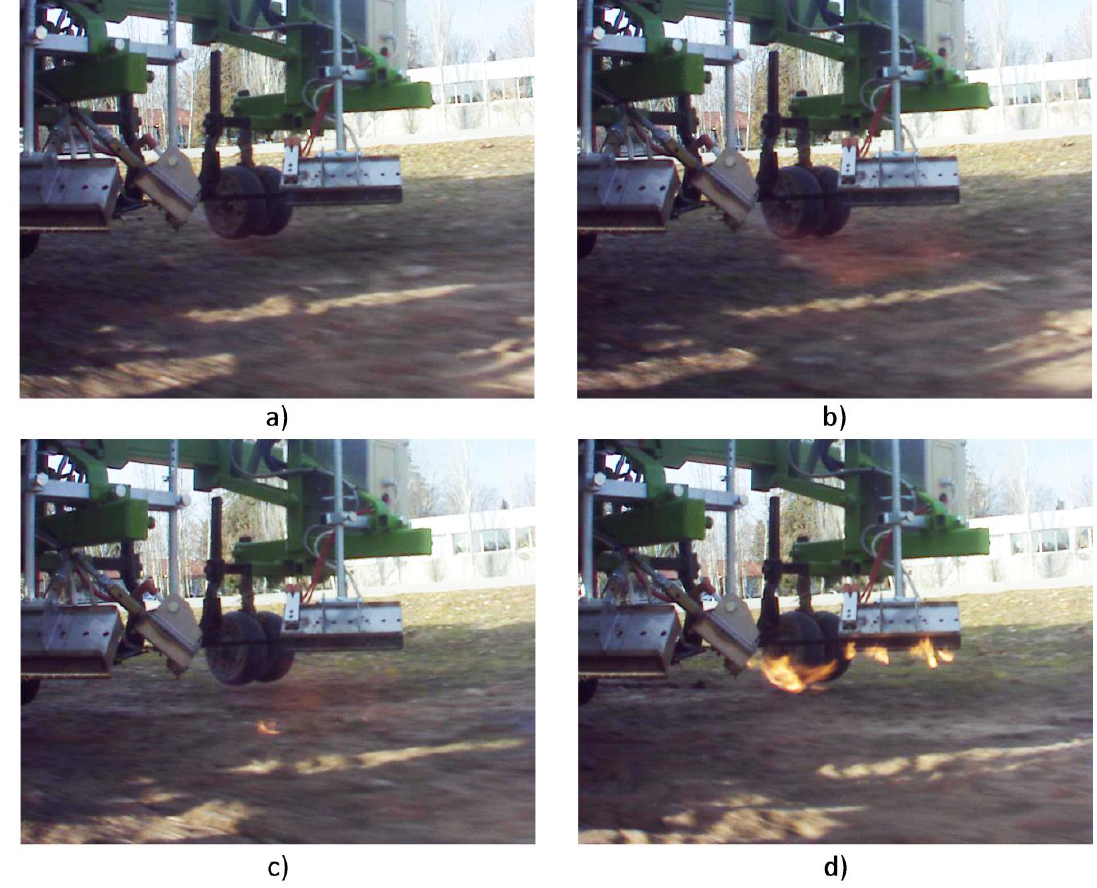
Figure 22. Example of the image sequence used for the calculation of the delay of the thermal treatment. ( a ) Detection of the ignition starting; ( b ) Detection of flame on the ground; ( c ) Detection of the withdrawal of the flame; ( d ) Detection of the total extinction of the